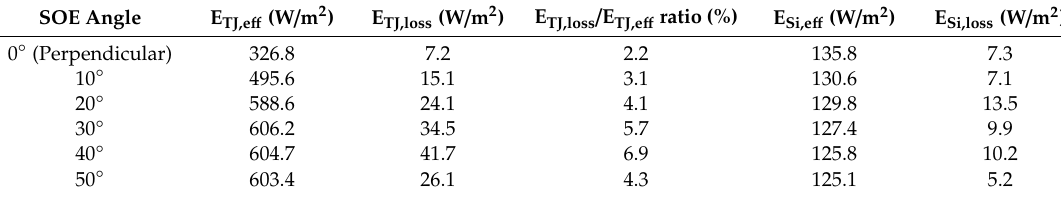
Figure 2. Secondary optical element (SOE) designs at a 15 mm height with di ff erent mirror angles of ( a ) θ = 0 ◦ , ( b ) θ = 10 ◦ , ( c ) θ = 20 ◦ , ( d ) θ = 30 ◦ , ( e ) θ = 40 ◦ , and ( f ) θ = 50 ◦ . Table 1. Irradiance on the triple-junction and silicon solar cells of the hybrid concentrator photovoltaic (CPV) module with di ff erent mirror angles and a 15 mm height, as calculated using the TracePro raytracing software. We separated the results into the e ff ective (0.3–1.299 µ m) and lossy (1.3–2.5 µ m) wavelength regions.